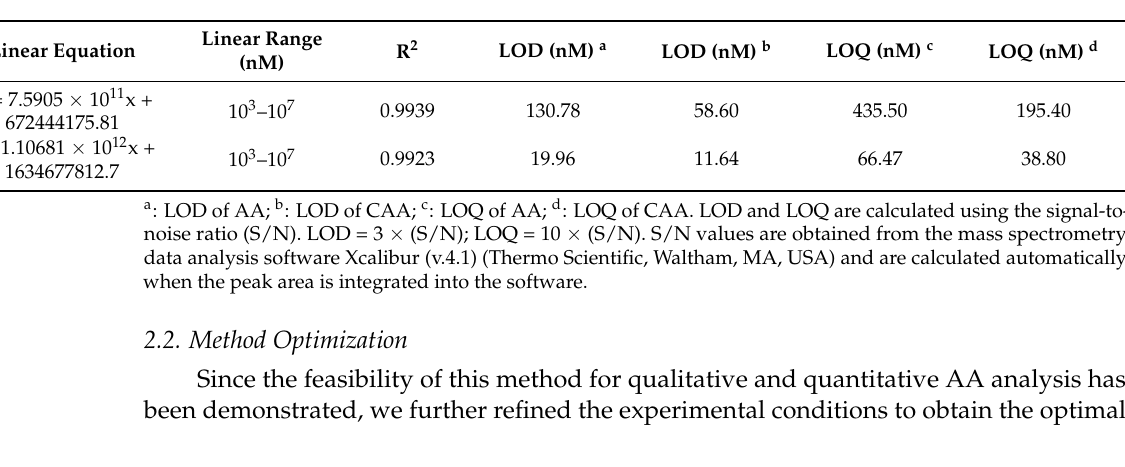
Table 1. Validation results of the LC-MS/MS method for the analysis of derivatized